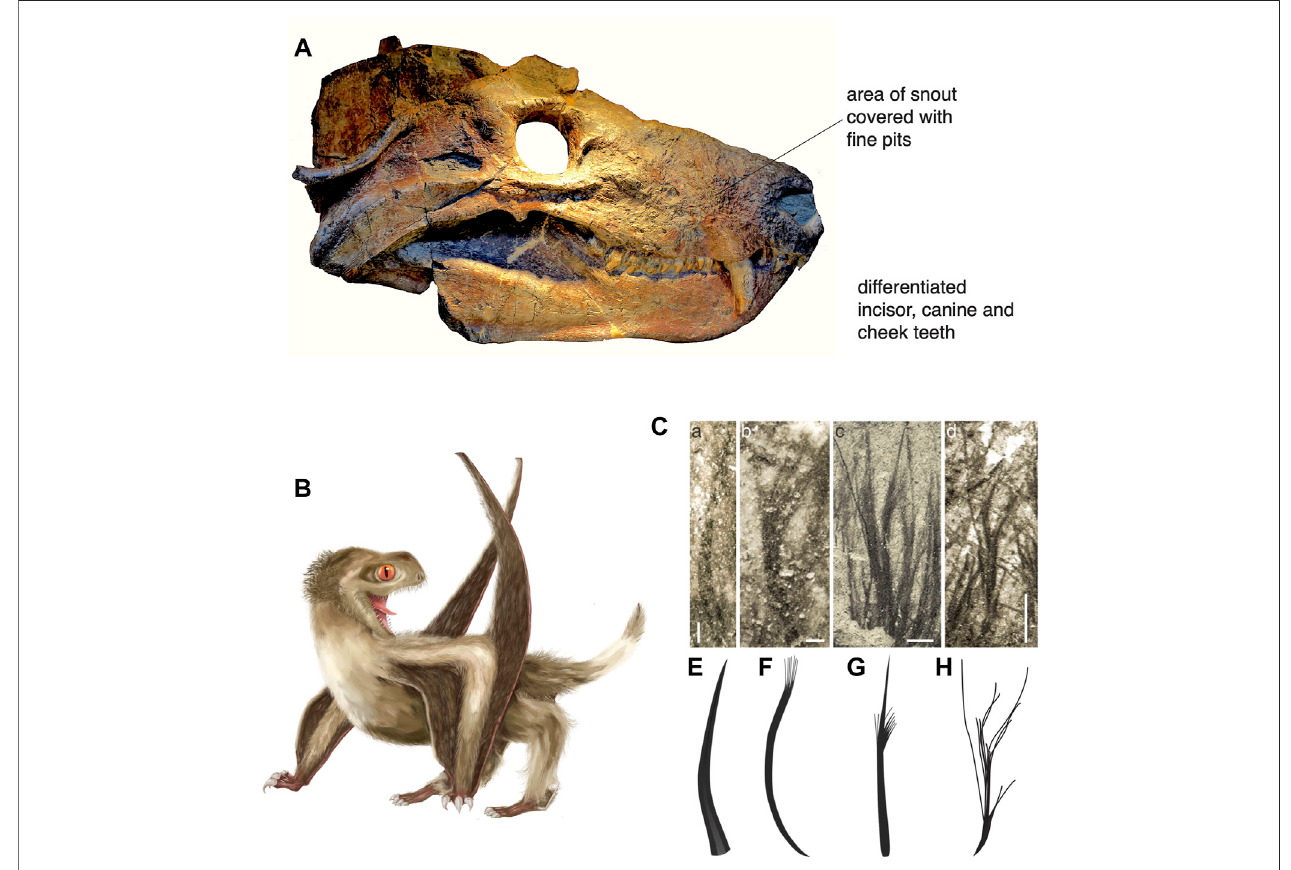
FIGURE 5 | Evidence for insulating pelage in synapsids (A) and archosauromorphs (B,C) . (A) Skull of the Middle Triassic cynodont Cynognathus in lateral view, showing pits on the snout suggesting vibrissae. (B) An anurognathid pterosaur from the Middle Jurassic of China, from which the four feather types were identi fi ed. (C) The four pterosaurian feather types: mono fi laments (a, e), tufted mono fi laments (b, f), bunched fi bres (c, g), and down feathers (d, h). (A) Photo by Emöke Dénes, Wikimedia; (B) artwork by Yuan Zhang; (C) Image based on Yang et al. (2019).